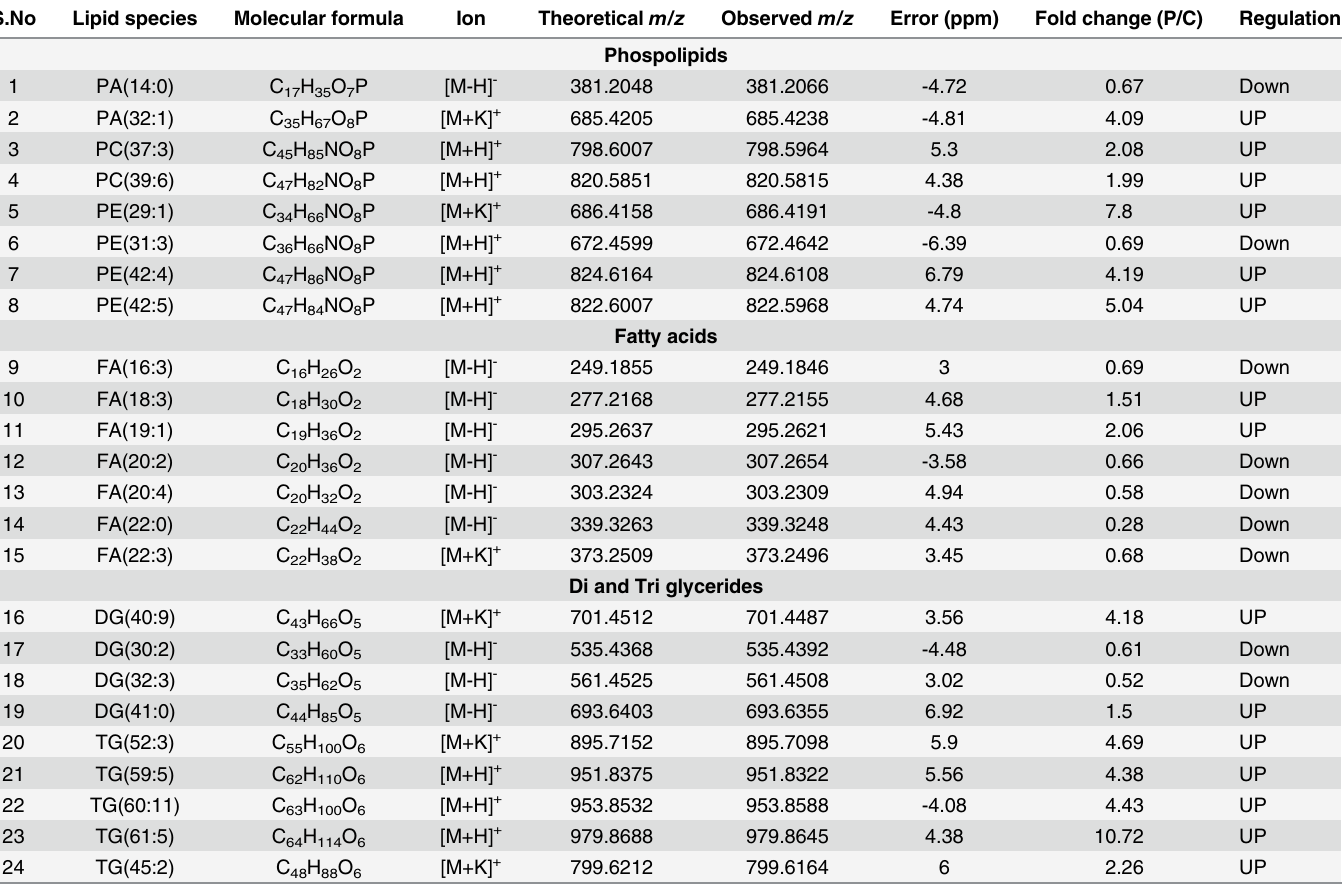
Table 2. High resolution mass spectral data. The identified metabolites in the lipid extracts of the serum